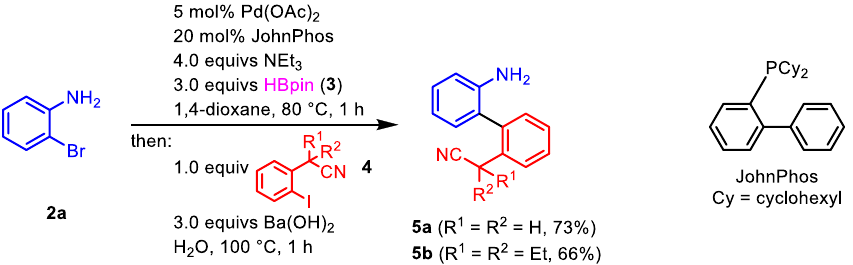
Figure 5. First concatenation of Masuda borylation and Suzuki coupling into a one-pot MBSC sequence by Baudoin et al. [30].